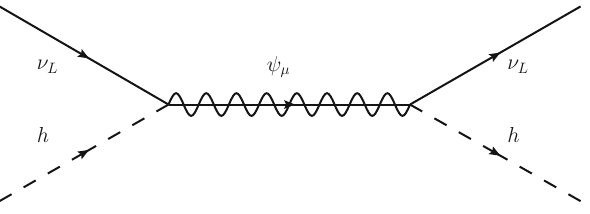
Fig. 3 ν L h → ν L h scattering with ψ μ mediation. No resonance can √ s = M because ψ DM cannot come to mass shell occur at